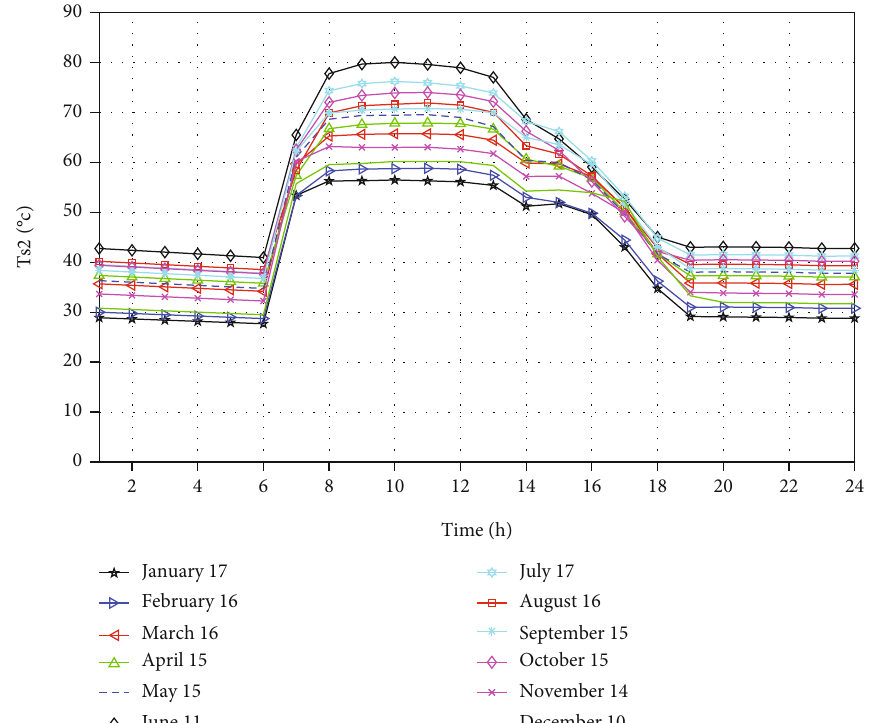
Figure 8: Storage water temperature at restaurant consumption pattern.